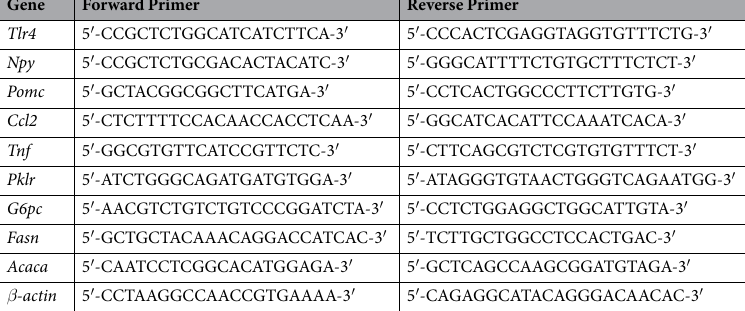
Table 1. The sequences of the primer used in real-time